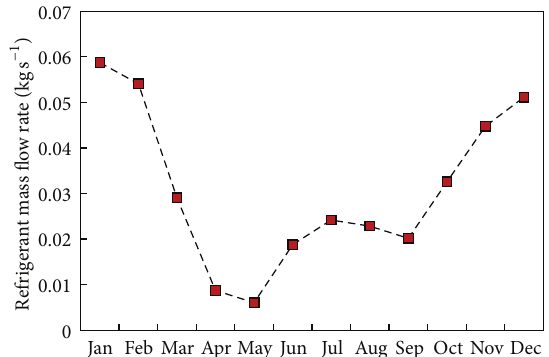
Figure 15: Heat pump refrigerant mass flow rate variation.